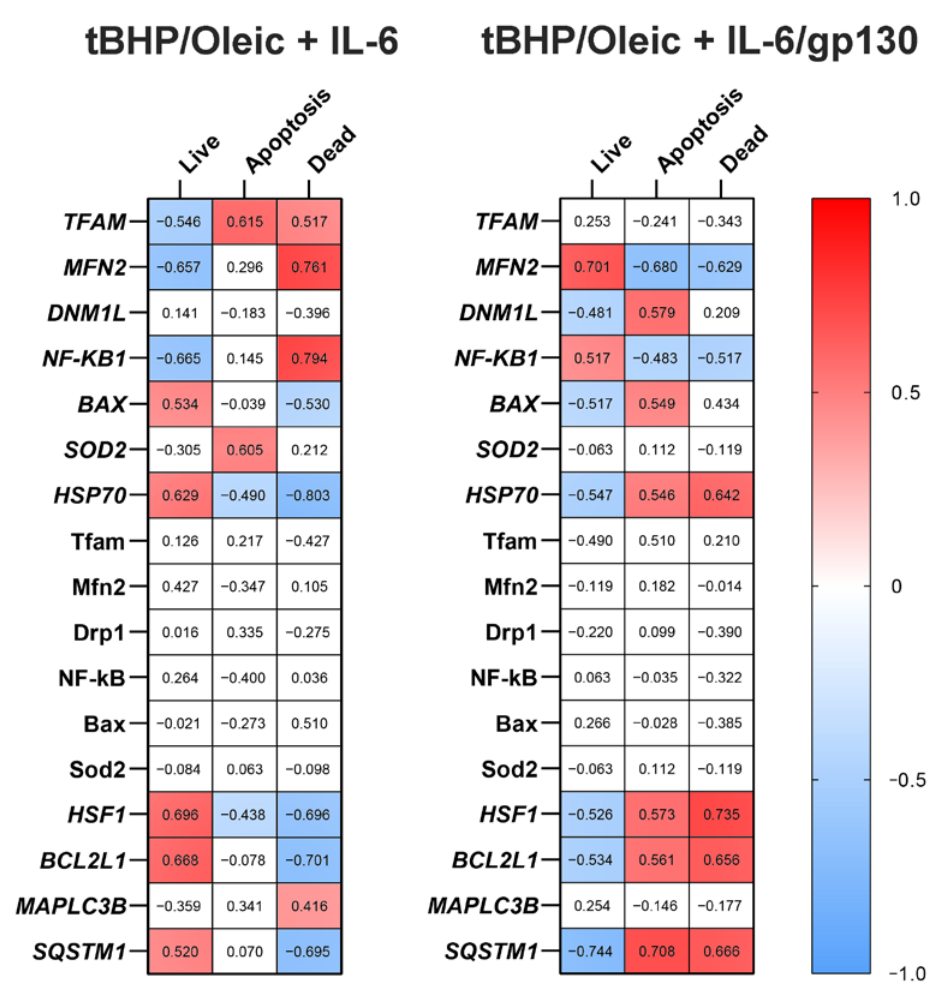
Figure 7. Correlations of the studied parameters with cell viability of the HepG2 cell model with tBHP/Oleic. Solid squares meant significant correlations ( p < 0.05), blue squares were negative correlations, red squares were positive correlations.